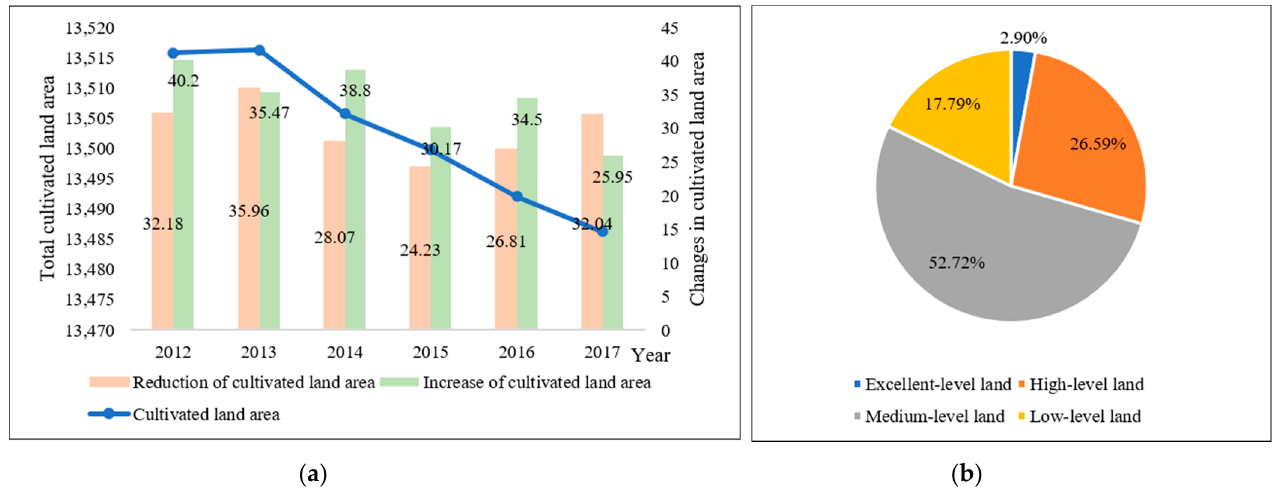
Figure 1. ( a ) Changes in cultivated land area in China from 2012 to 2017. ( b ) Grade structure of cultivated land quality in China.